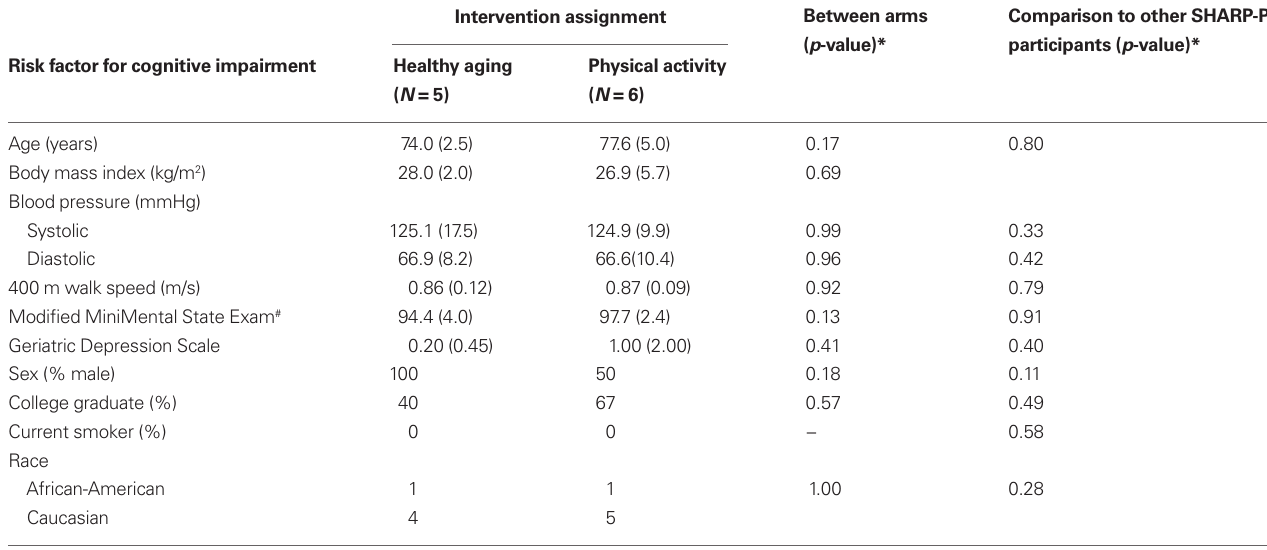
Table 1 | Distribution of risk factors for cognitive impairment at baseline for individuals grouped by intervention assignment. Intervention